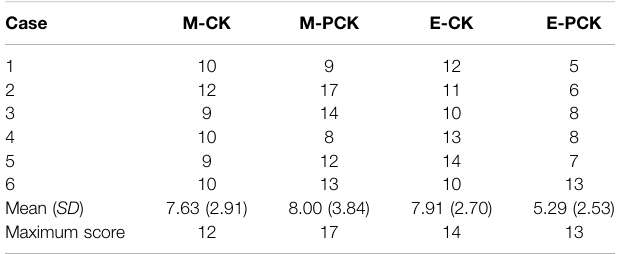
TABLE 1 | Knowledge test scores in mathematics (M-CK, M-PCK) and economics (E-CK, E-PCK) for the six selected cases compared to the means in the overall sample ( N (cid:1)